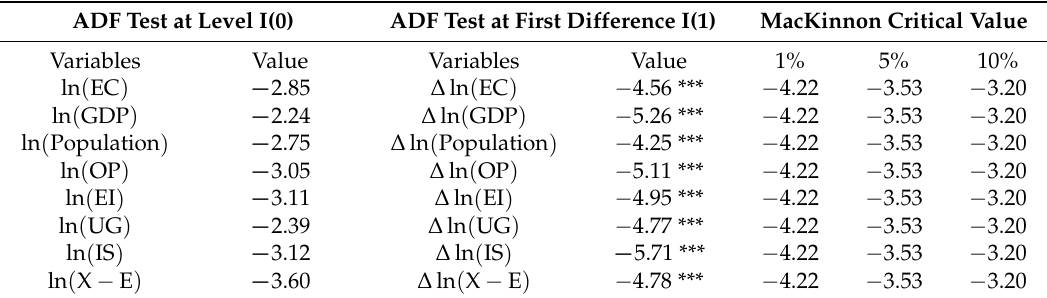
Table 1. Unit root test at Level I(0) and First Difference